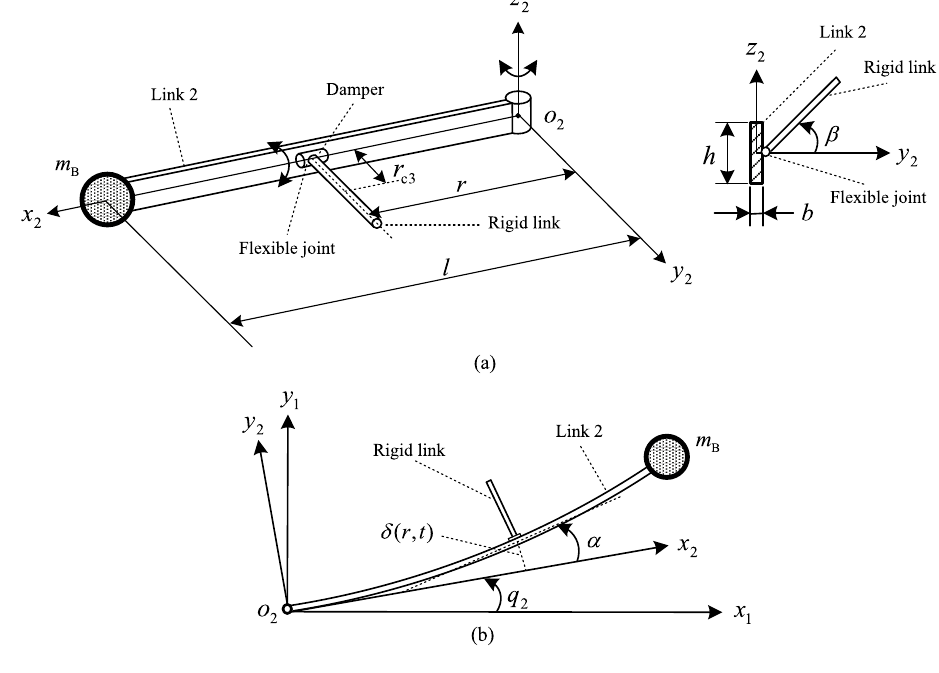
Fig. 3. Model of the flexible link with a vibration